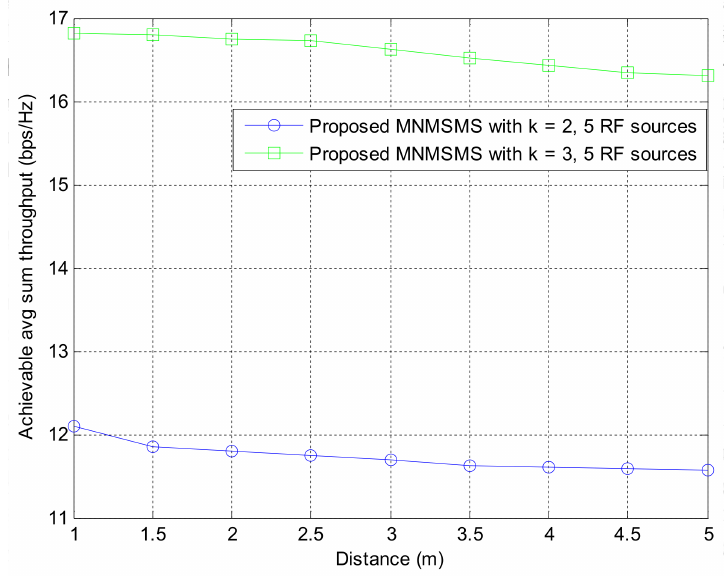
Figure 5. The impact of different networks distance from the base station on the system-achievable throughput